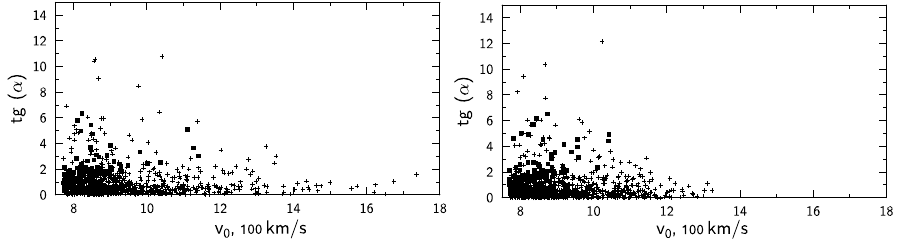
Fig. 1. The distribution of the angle (cid:11) between the initial velocity vector and the Galactic plane versus the initial velocity v 0 of the star, in the units of 100 km s − 1 , for simulations with the semimajor axis of a binary system equal to 282 R ⊙ and the pericentric distances 10 000 R ⊙ (the left panel) and 15 000 R ⊙ (the right panel). The pluses and squares denote the hypervelocity and non-escaping stars, respectively.